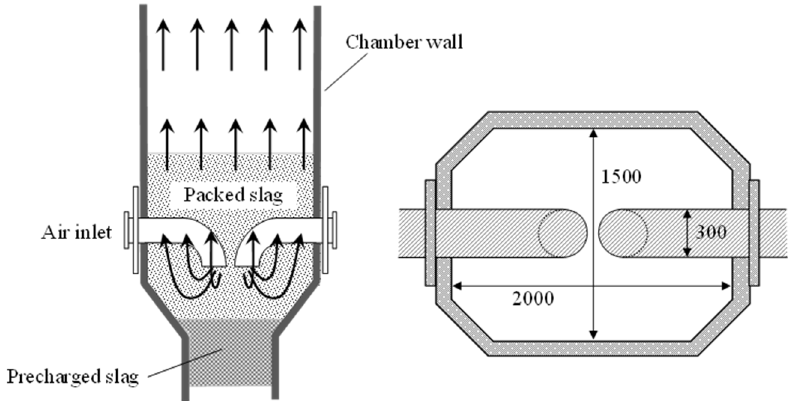
Figure 10. Vertical and horizontal cross sections of pilot-scale slag heat recovery chamber.